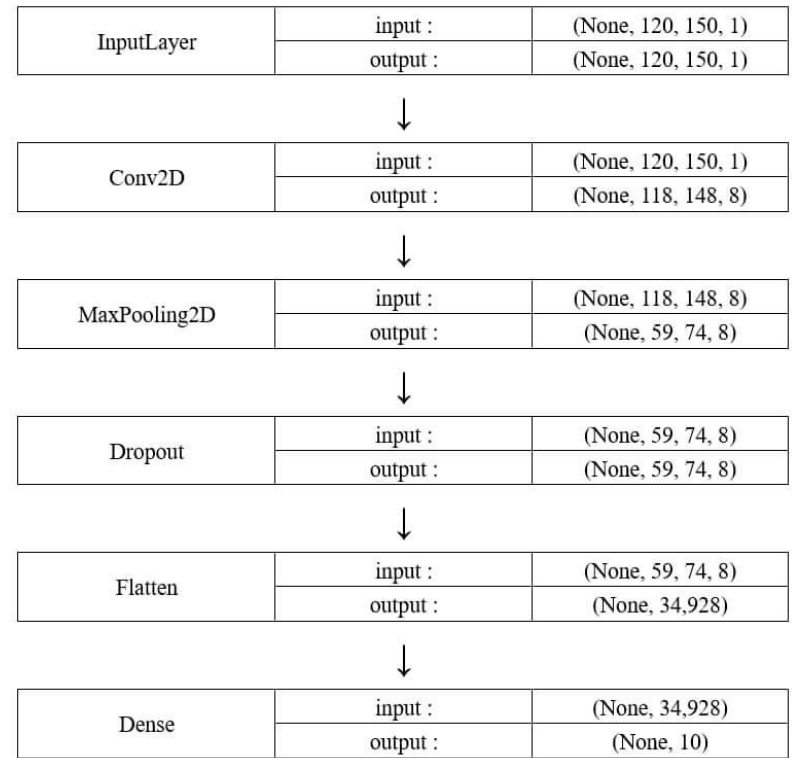
Figure 7. Structure of the CNN model.